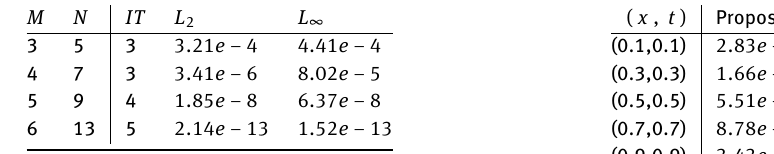
Table 7: A comparison of the proposed method and results of [18] to solve example 3.